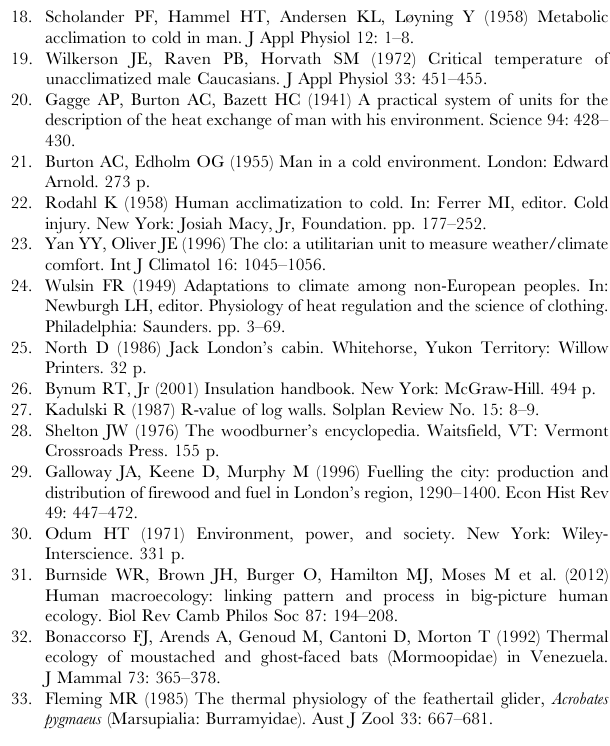
Table S3 Estimation of conductance C of Jack London’s cabin. Information on cabin construction and dimensions was obtained from published descriptions [25] and historical photo- graphs. To minimize chances of error arising from unit conversions, calculations were carried out in the units customary in the United States building industry, and the final result was converted to W u C 2 1 . Area-specific U , which is the inverse of the customary R value for building insulation, measures the thermal conductance of building materials. We used values of area-specific U and R from standard tabulations [26–28]. Air infiltration is inevitable, adding to the demand for heat to keep the inside at